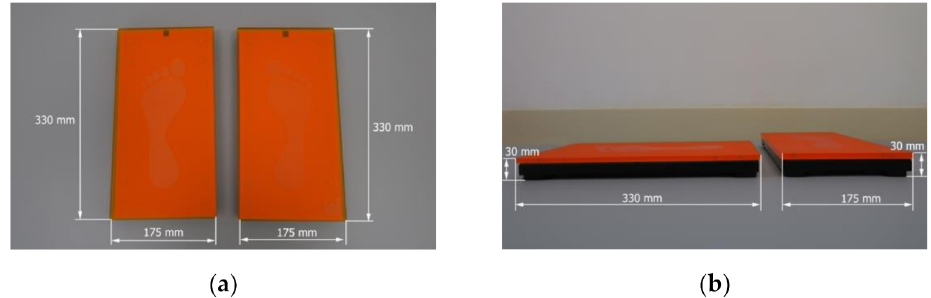
Figure 2. Technical characteristics of K-Force Plates separately for right and left limbs: ( a ) Length and width; ( b ) length, width, and height. The weight exceeds 1600 g.